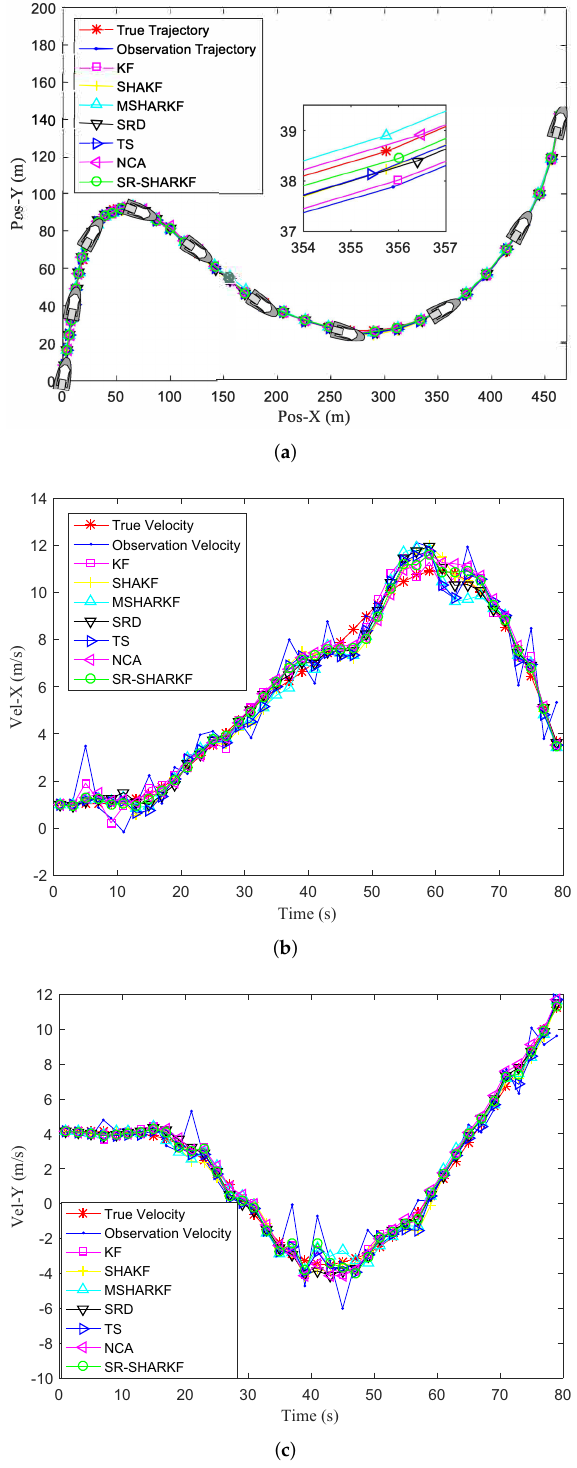
Figure 3. Filtering effect in terms of position and velocity. ( a ) Target trajectory. ( b ) Target velocity in the X-axis direction. ( c ) Target velocity in the Y-axis